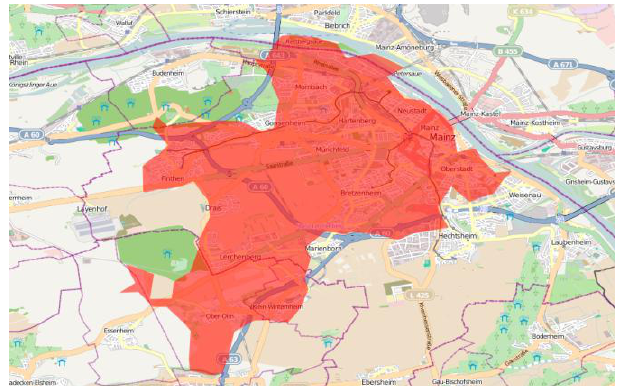
Figure 12. Example activity area of a member of the OSM